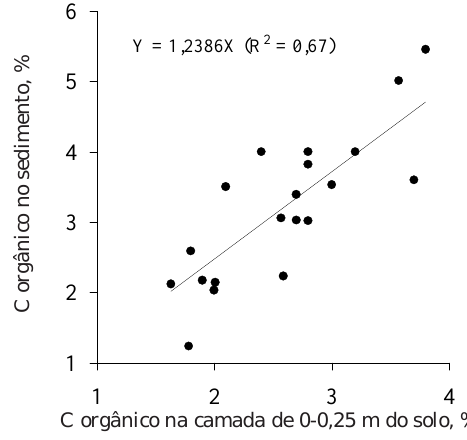
Figura 2. Relação do carbono orgânico contido